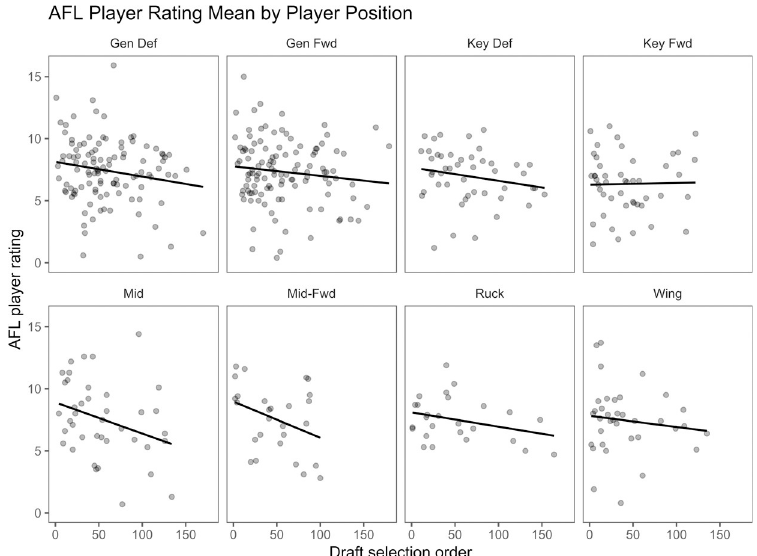
Fig 6. Relationship between draft selection order and AFL Player Rating mean relative to playing